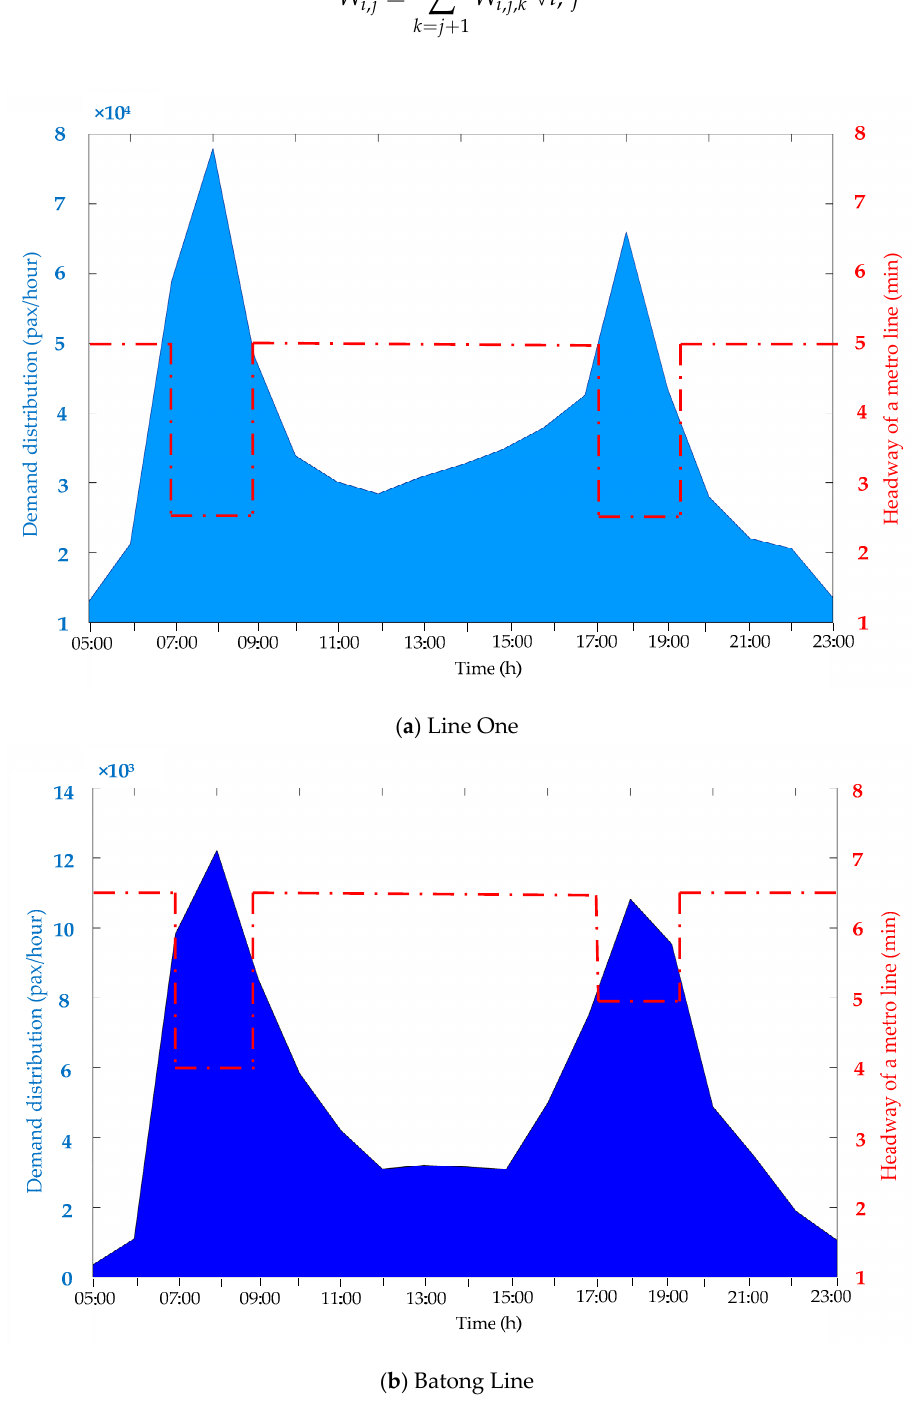
Figure 3. Interaction between passenger distribution and headway on two metro lines.